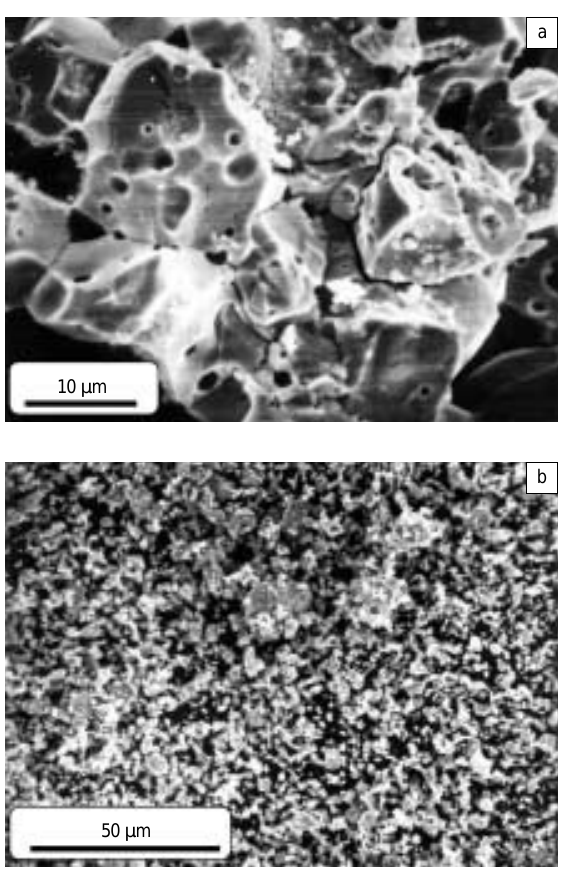
Fig. 7 Microphotograph of the SHS product in the system Ni 55 wt.% Ge (a), the same product after mechanical activation for 2